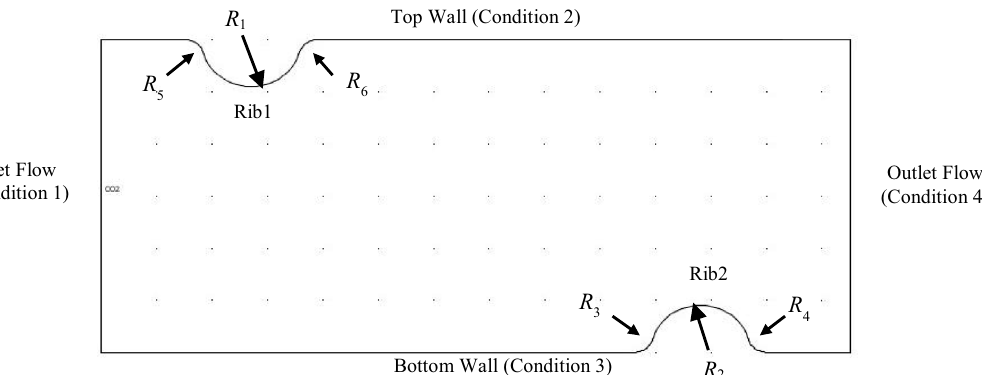
Fig. 7. Periodic section of cooling passage with design variables R 1 , R 2 , R 3 , R 4 , R 5 , and R